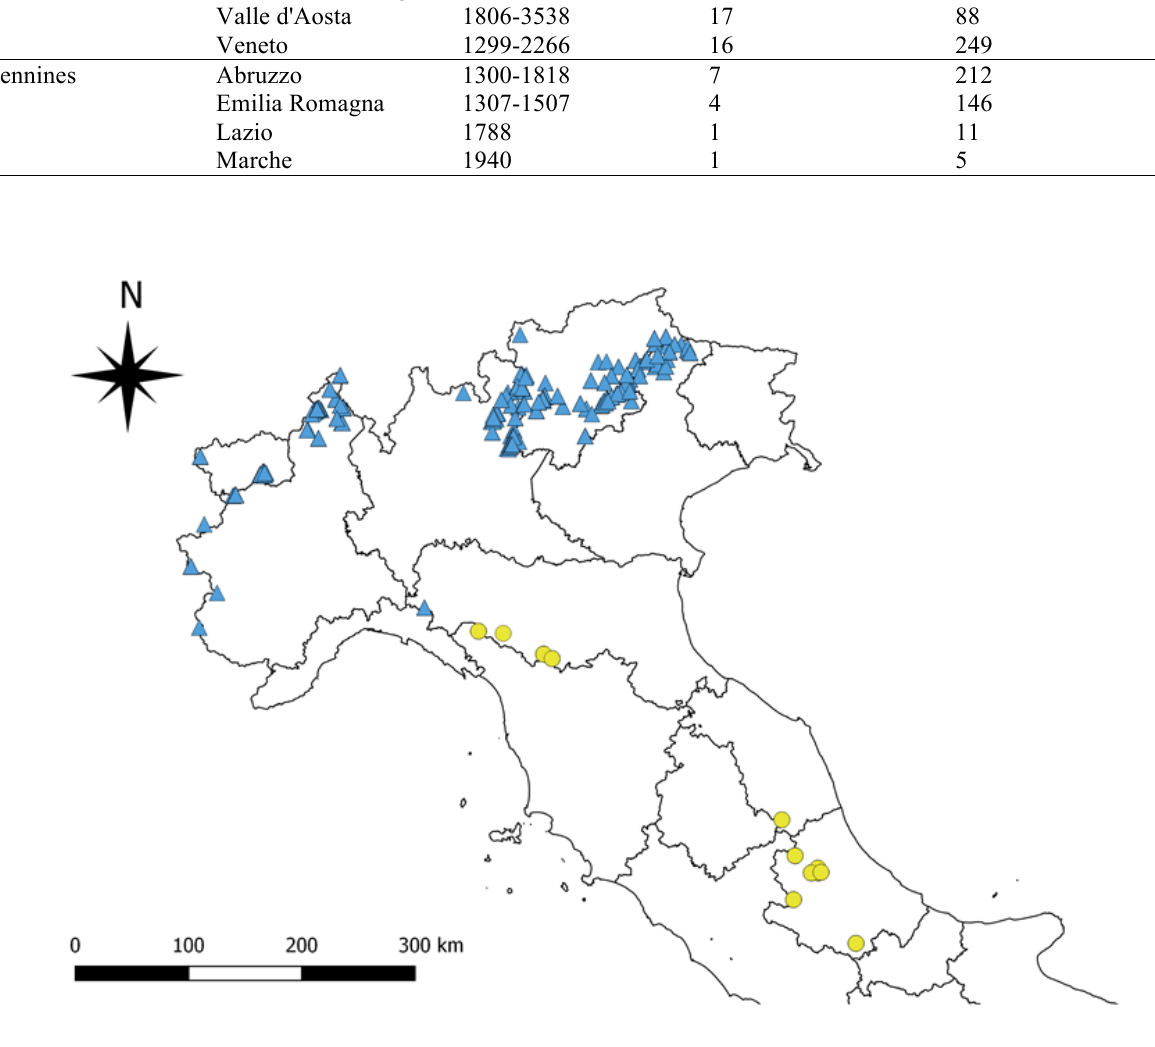
Figure 1. Location of the mountain lakes considered in the present work distributed in Northern and Central Italy. Δ Alpine lakes, ○ Apennine